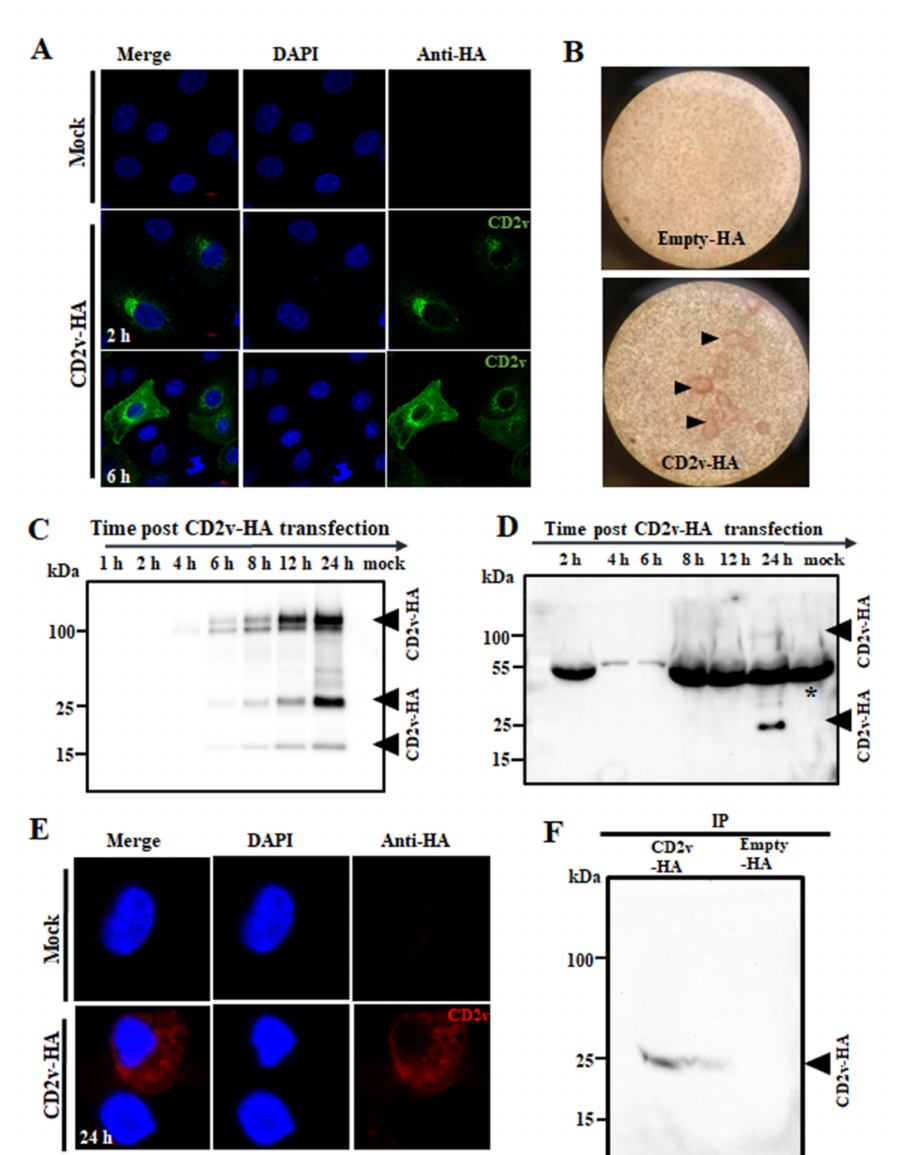
Figure 1. Subcellular localization and expression kinetics of ASFV CD2v. ( A ) PK15 cells were mock transfected or transfected with pCD2v-HA, fixed at various times pt, incubated with anti-HA primary antibody, sequentially stained with Alexa fluor 488-labeled secondary antibody and DAPI and examined by confocal microscopy. ( B ) CD2v-HA-expressing PK15 cells hemadsorbed swine red blood cells (RBCs). PK15 cells were transfected with plasmid pCD2v-HA for 24 h, incubated with swine RBCs overnight and examined using light microscopy ( × 100). CD2v-dependent rosetting is indicated by the arrowheads. ( C ) PK15 cells mock transfected or transfected with pCD2v-HA were harvested at the indicated times pt and total cell protein extracts were resolved by SDS-PAGE, blotted and incubated with antibodies against HA. ( D ) Detection of CD2v in the culture supernatant. PK15 cells were transfected as above and supernatants harvested at various times pt. Cleared supernatants (50 µ L) were resolved by SDS-PAGE and analyzed by Western blot using antibodies against HA. * denotes the non-specific background band due to serum proteins in the supernatant. ( E ) Primary swine macrophages were mock transfected or transfected with a pCD2v-HA, fixed at 24 h pt, incubated with anti-HA primary antibody, sequentially stained with Alexa fluor 594-labeled secondary antibody and DAPI and examined by confocal microscopy. ( F ) Detection of CD2v in the culture supernatant of primary swine macrophages transiently expressing CD2v. Cells were transfected as above, incubated for 24 h and supernatants were immunoprecipitated with anti-HA antibody, resolved in SDS-PAGE and probed with the anti-HA antibody. Results for ( A – F ) are representative of two independent